Question: Generate an informative caption for the figure above.
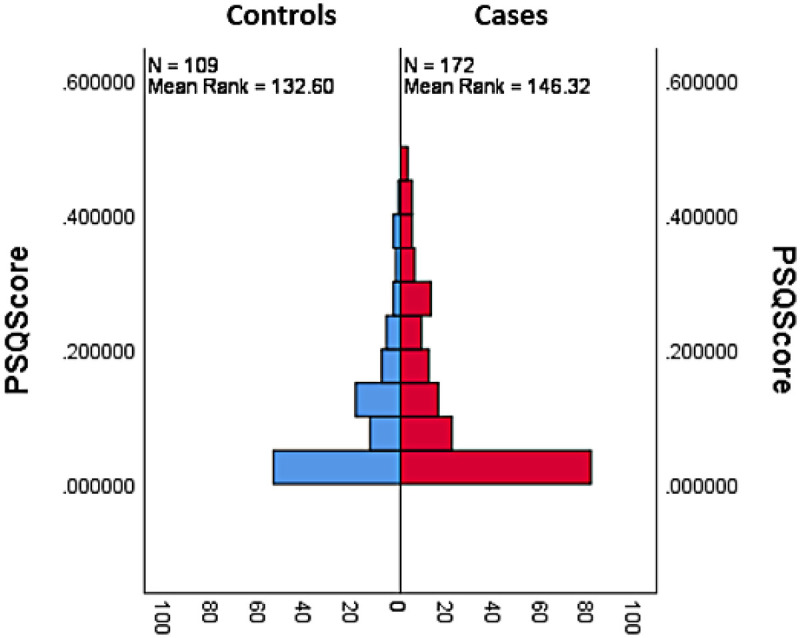
Answer: Display of the difference between cases and controls in terms of the variation of the PSQ score across the study sample, according to the U Mann–Whitney test.